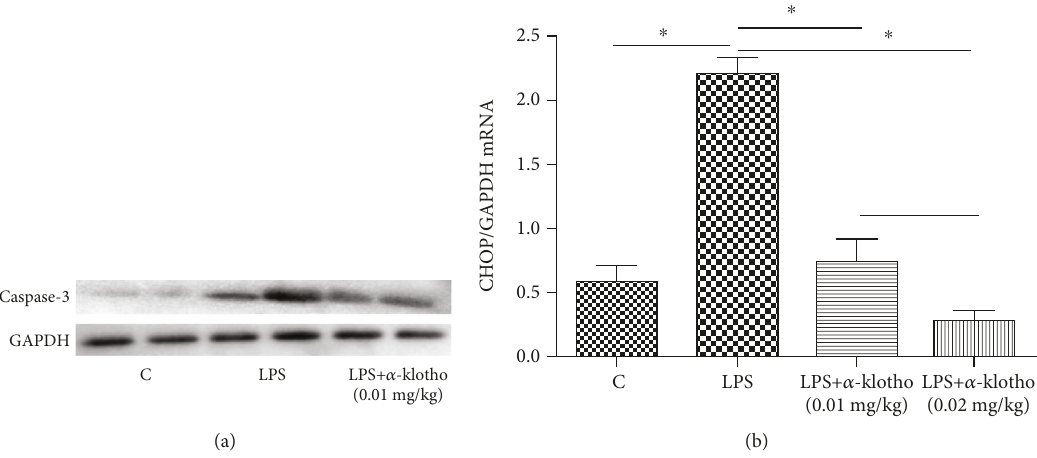
Figure 4: α -Klotho reduced LPS-induced apoptosis in mouse heart (a, b). Mouse heart tissues were collected from the control group, LPS group, and LPS+ α -klotho (0.01 mg/kg) group at 24 h after LPS injection. The levels of heart caspase-3 (a) were measured by western blotting. The expression of heart CHOP mRNA (b) was measured by real-time PCR. ∗ p < 0 05